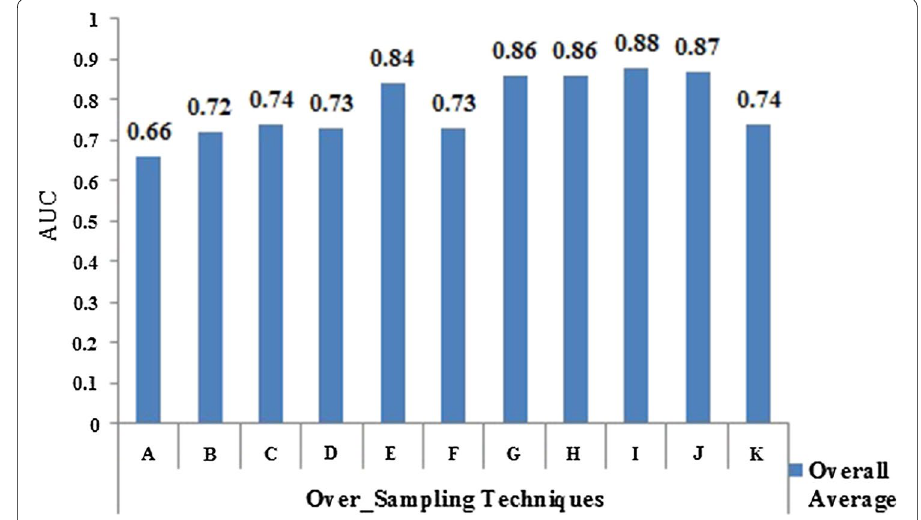
Fig. 10 Average AUC values for binary class Structured data set